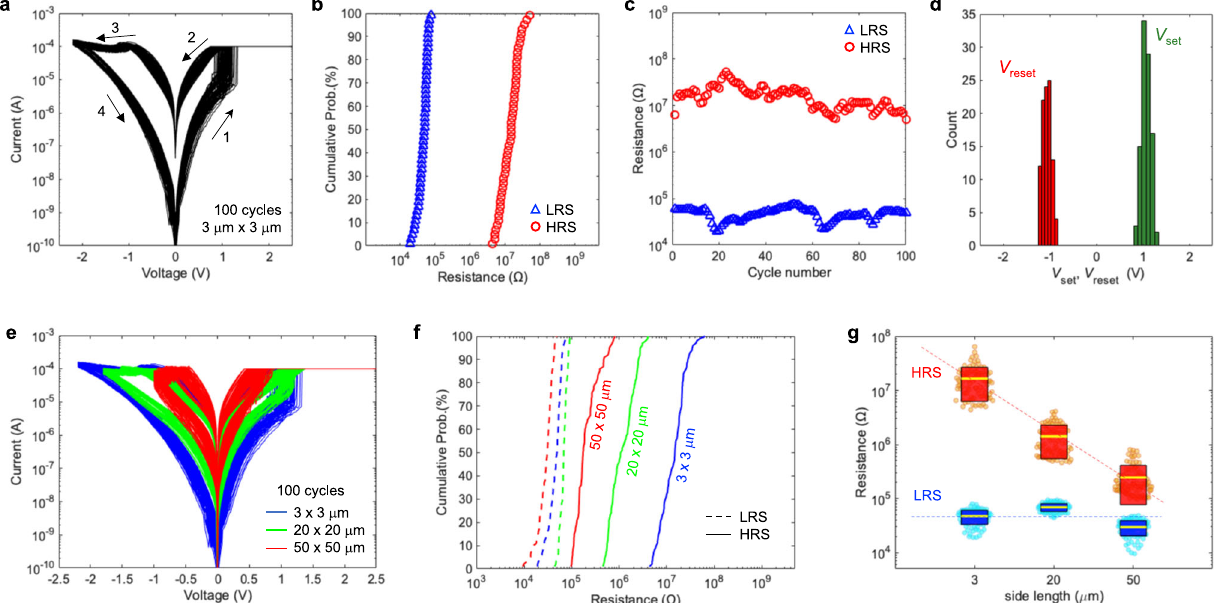
Fig. 2 Resistive switching characteristics of h-BN memristors. a Representative I – V characteristics measured during 100 cycles in one single 3 µm × 3 µm Au/h-BN/Ti memristor with 0.1 and 1 mA compliance respectively for the positive and negative sides of the sweep. b Cumulative probability distribution of the HRS and LRS (read at 0.1 V) c resistance vs cycle number plot, and d histogram of set and reset voltages. e Comparison of 100 I – V cycles from Au/h-BN/Ti memristors with different active areas. f Cumulative probability distribution of the HRS and LRS (read at 0.1 V) and g statistical analysis of resistance (HRS, LRS) as a function of the active area side